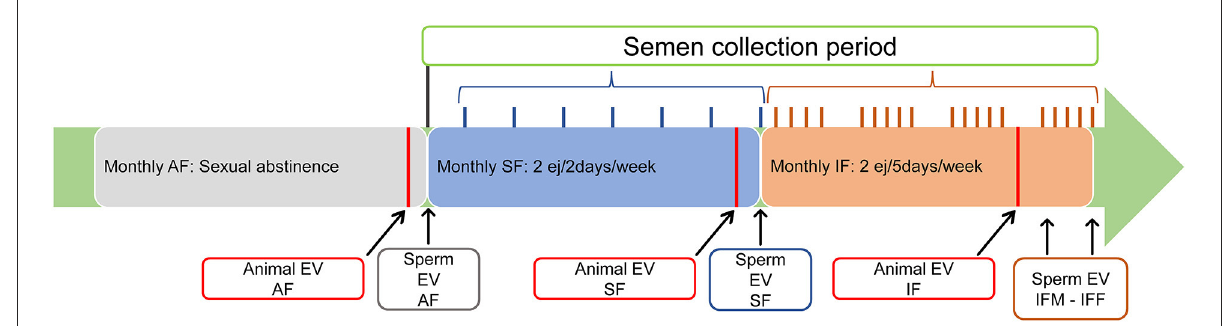
FIGURE1 Experimental design. All three semen collection frequencies were extended for 1 month. Animal evaluation (Animal EV): clinical examination (inspection and palpation of external genitalia, libido, and blood collection) and ultrasonography evaluation (testicular volume, echotexture, and blood flow) were carried out at least 24h before experimental semen collection). Sperm evaluation (Sperm EV): sperm production, motility, and physiology were performed at the end of the evaluated semen collection frequency. AF, abstinence semen collection frequency; SF,